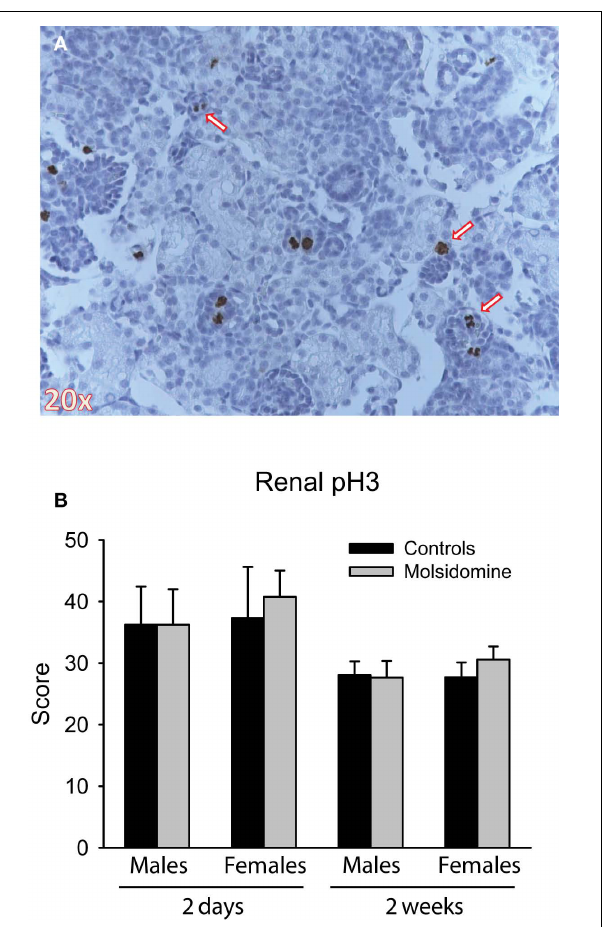
FIGURE 6 | Phospho-histone H3 (pH3) immunohistochemistry. Histology was performed on the kidneys from 2day, 2week and adult control and molsidomine FHH rats of both genders for pH3. An example of positive staining for pH3 in 2day female molsidomine-treated FHH rat is shown in (A) . Several arrows indicate cells in mitosis staining positive for pH3.The number of positive cells at 2days and 2weeks is shown in (B) . Note that data in adults is not shown as all stained sections were completely negative for